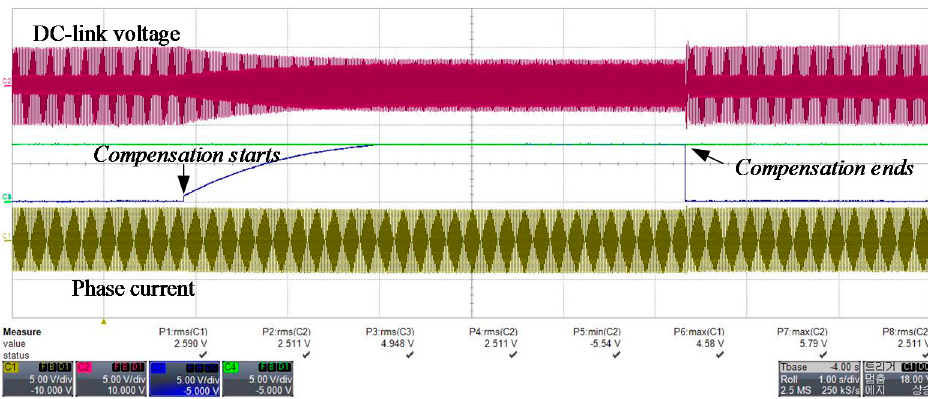
Figure 12. Experimental results of DC-link voltage and grid phase current when the proposed compensation is started and ended.